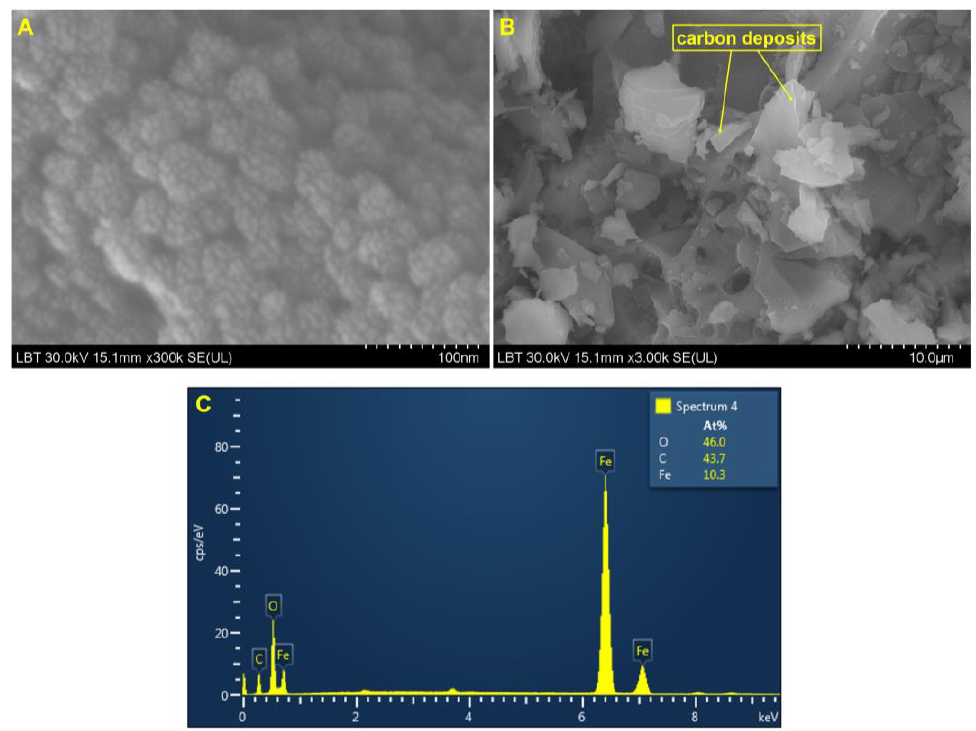
Figure 6. SEM images for MIONPs synthesized via the combustion method at different orders of magnitude: scale bars ( A ) 100 nm, ( B ) 10 µm, and ( C ) EDX spectrum. magnitude: scale bars ( A ) 100 nm, ( B ) 10 µ m, and ( C ) EDX